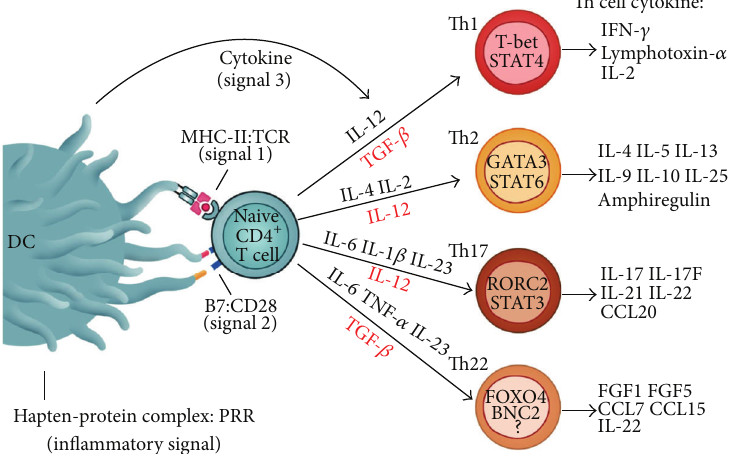
Figure 2: Polarization of different Th cell subpopulations by one inflammatory signal and three DC derived signals. Skin resident LCs and dermal DCs recognize a complex of skin penetrating haptens and proteins via PRRs. Subsequently, these cells mature and display antigenic epitopes to TCRbearing T cells in the lymph node. Theallergen is presented by MHC molecules (signal 1) and costimulatory molecules deliver a signal 2. The profile of differentiating cytokines and growth factors released by activated DCs is crucial for the development of individual Th cells. These are characterized by expression of transcription factors such as T-bet, GATA3, RORC (human counterpart of murine ROR 𝛾 t), FOXO4, and release of signature cytokines such as IFN- 𝛾 for Th1, IL-4 for Th2, IL-17 for Th17, and IL-22 for Th22. PRR, pattern recognition receptor; Th, T helper